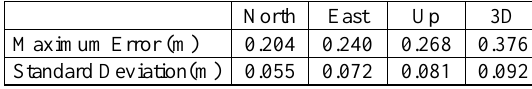
Table 2. Maximum errors and its standard